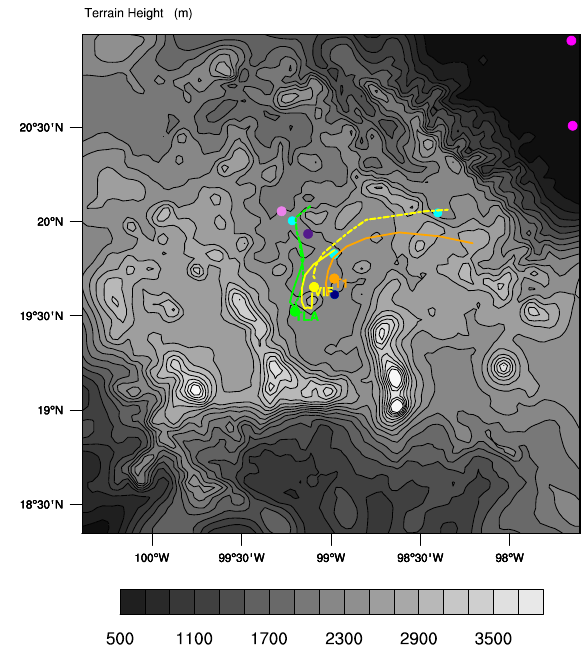
Figure 3. Backward trajectories at TLA (green), VIF (yellow) and T1 (orange) at two levels: 250ma.g.l. (dashed), 750ma.g.l. (solid). Filled circles maintain the same notation as Fig. 1b: Atotonilco, Ti- zayuca and Tulancingo (cyan); FPRPP (violet); Apaxco (purple); VMPP (blue); Tuxpan and Poza Rica (magenta). The plot corre- sponds to 24 March